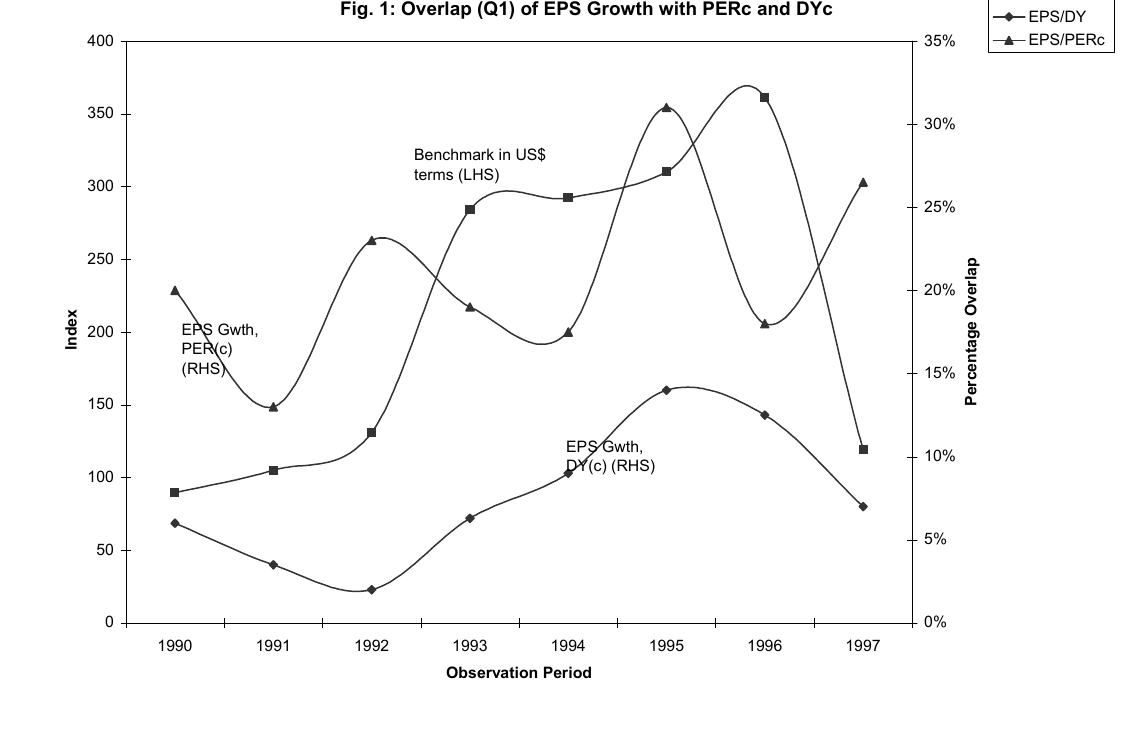
Fig. 1: Overlap (Q1) of EPS Growth with PERc and